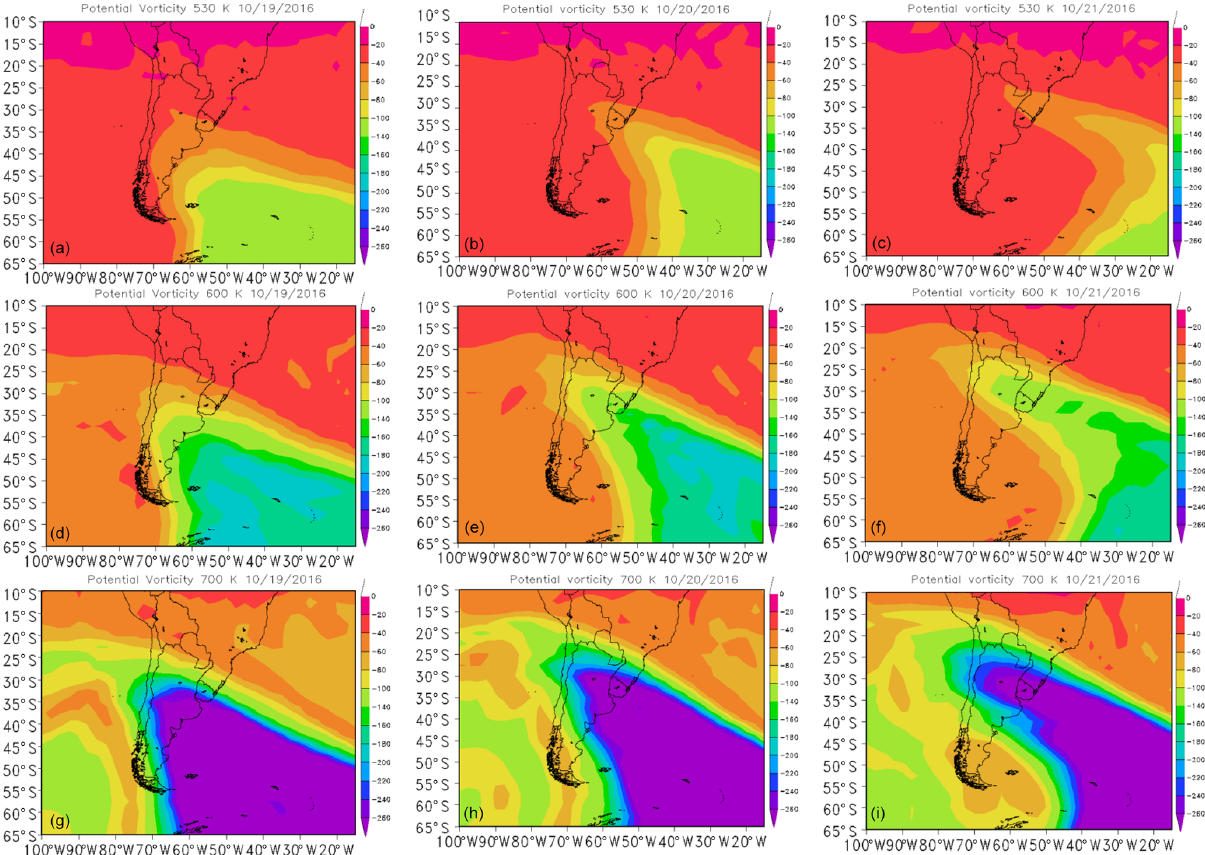
Figure 2. Potential vorticity for the potential temperature levels of 530K ( a , b , and c ), 600K ( d , e , and f ), and 700K ( g , h , and i ). The color scale ranges from 0 to 260 and shows the increase in